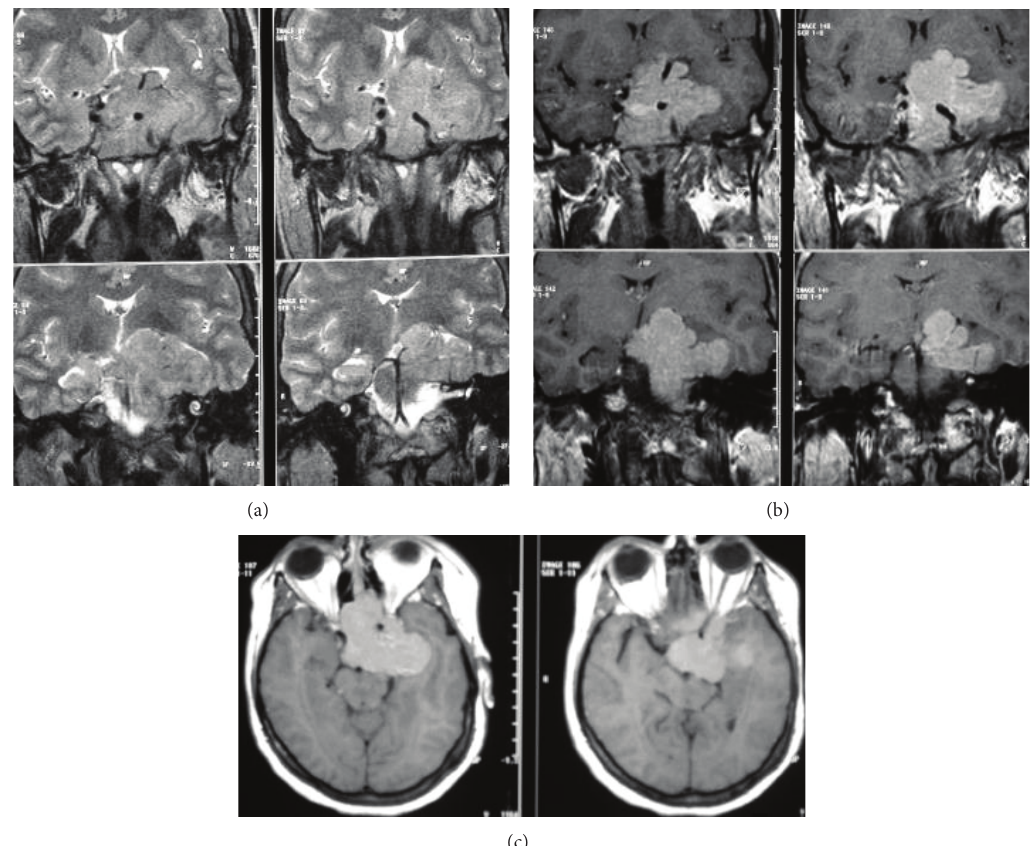
Figure 1: (a) Coronal T2-weighted turbo spin echo magnetic resonance image shows solid macroadenoma filling the entire sella, invading left cavernous sinus, and obliterating the suprasellar cistern; (b)-(c) postcontrast coronal (b) and axial (c) spin echo images show that the mass enhances intensely and homogenously. The extention of the macroadenoma in the prepontine cistern and the encasement of cavernous portion of the left internal carotid artery were more prominent in these